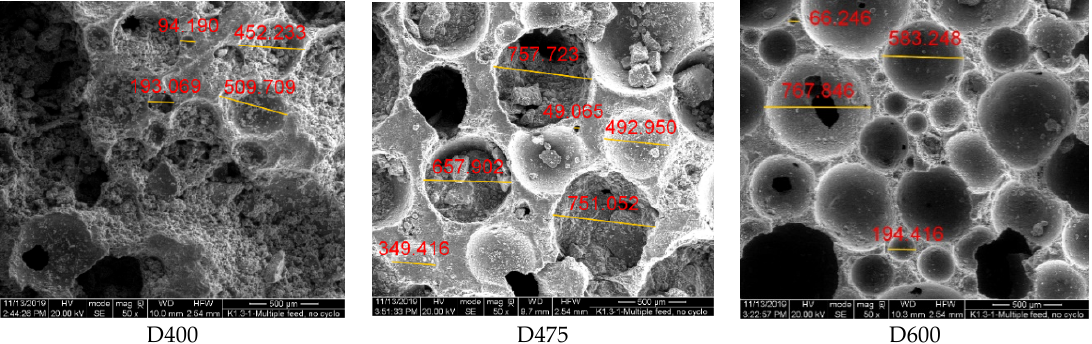
Figure 5. ESEM images with different densities.